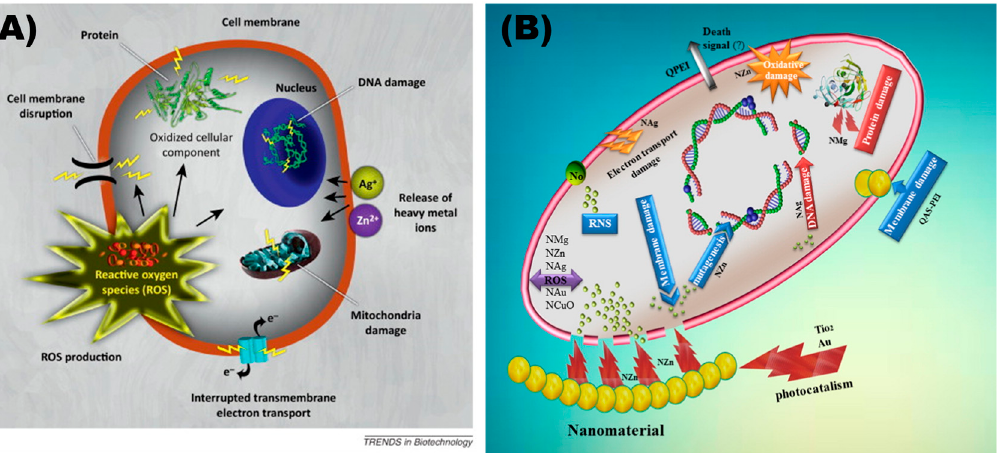
Figure 1. The provision of various antibacterial mechanisms by nanoparticles. Nanoparticles and the ions they release produce free radicals that induce oxidative stress, which induces bacterial death. ( A ) Reproduced with permission [31]. Copyright 2012, Elsevier. ( B ) “?” represented that there is no consensus on the signal of bacterial death caused by nanomaterials. Reproduced with permission [41]. Copyright 2017, Elsevier.